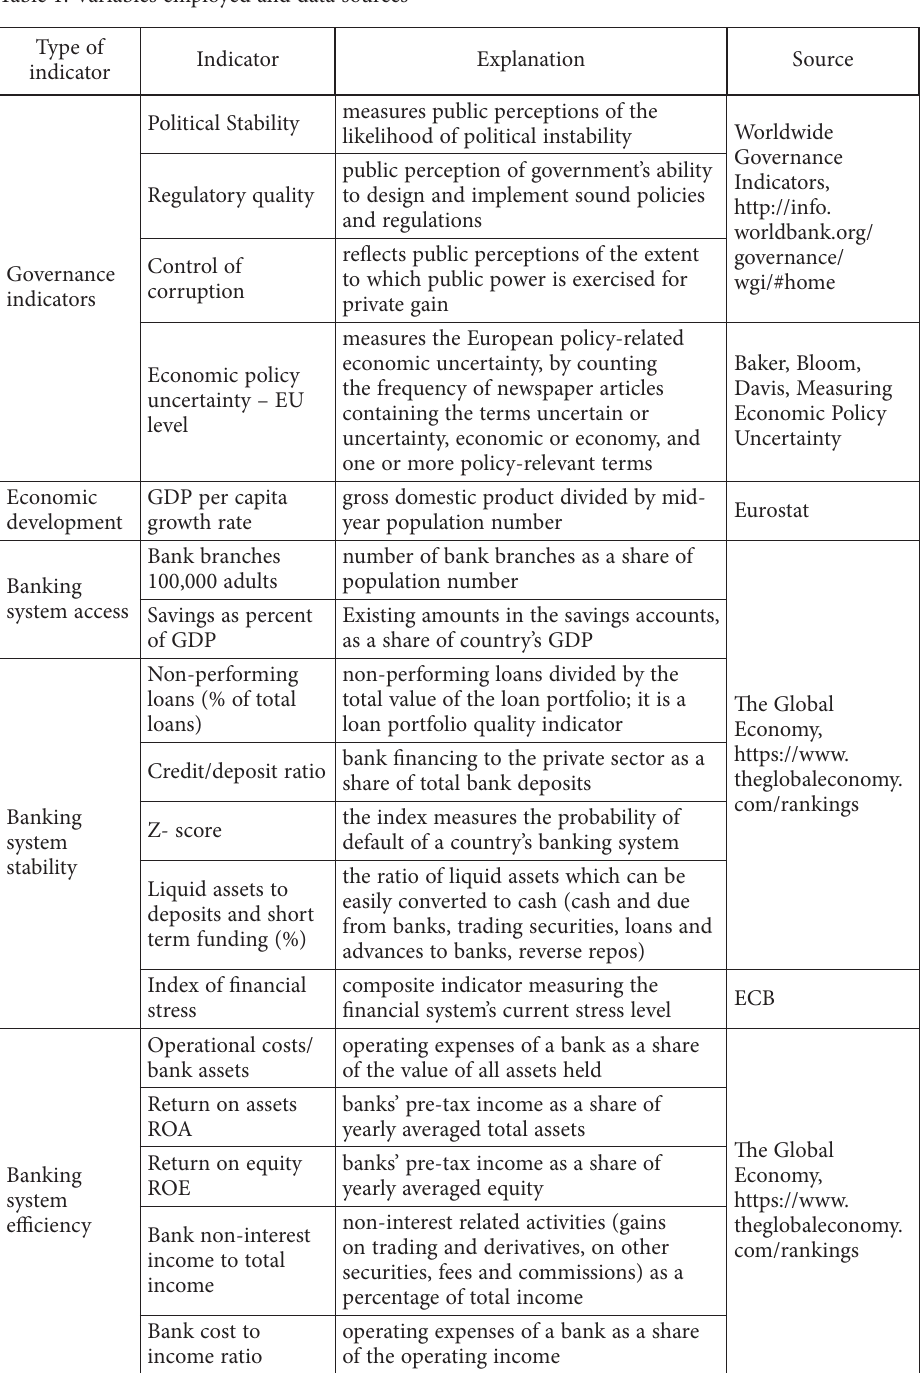
Table 1. Variables employed and data sources Type of